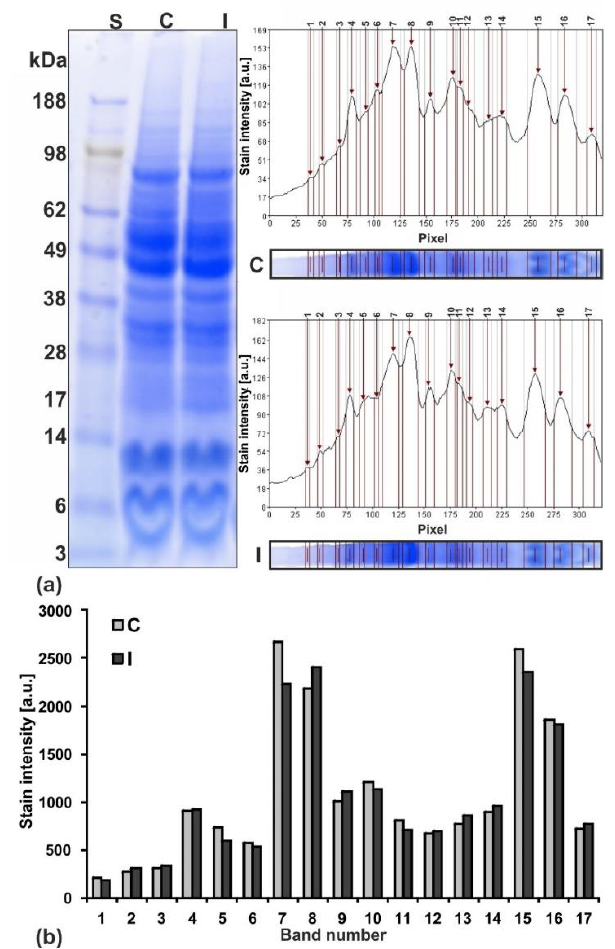
Figure 3. Protein profile in yellow lupine cotyledons from the seeds collected from not irrigated—(control C) and irrigated—(I) plants. ( a ) Electrophoretic separation of proteins in polyacrylamide gel (stained with Coomassie Blue) and computer analysis of staining intensity of the detected bands. Channel 1 shows protein mass standard (S), two and three show seed proteins from non-irrigated (control C) or irrigated (I) plants, respectively. ( b ) Comparison of protein contents in 17 detected bands.